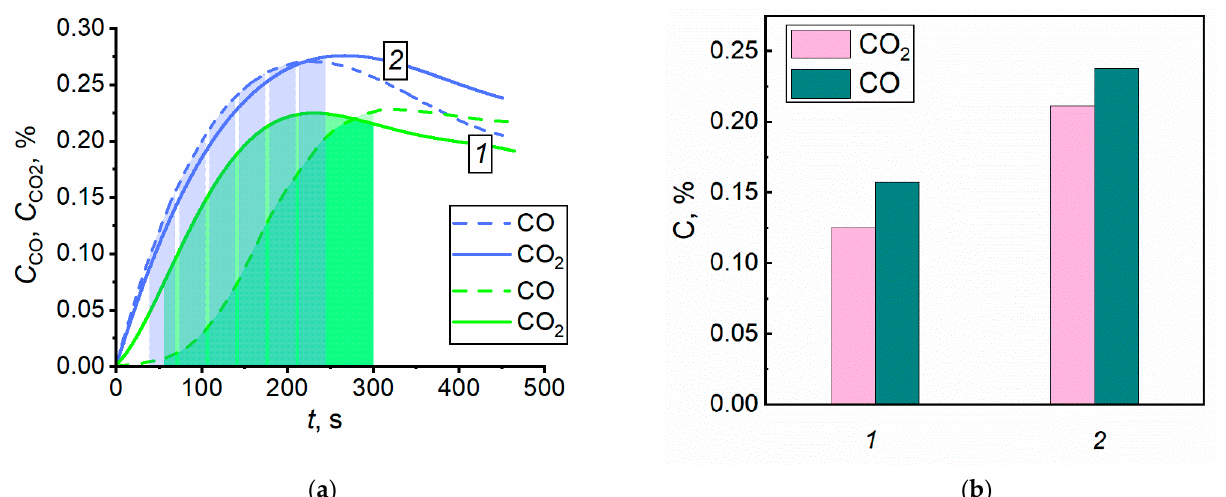
Figure 5. Trends of CO 2 and CO ( a ) recorded in the cycling and continuous suppression of timber fires. Average concentrations of CO 2 and CO ( b ): 1 —continuous water supply; 2—cycling spraying.